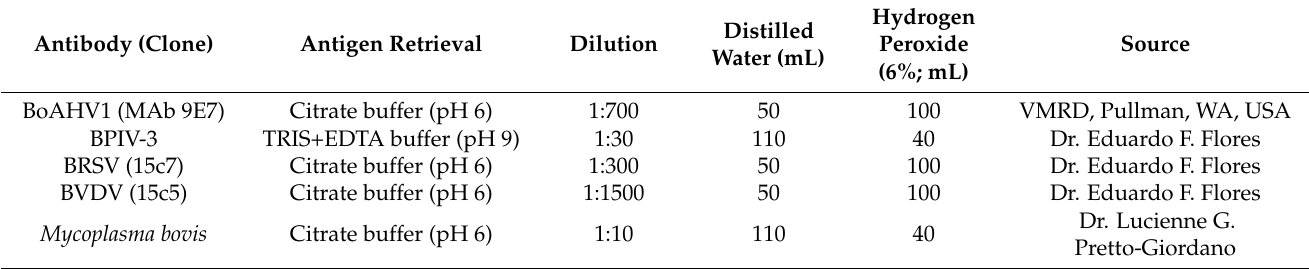
Table 1. Antibodies, dilutions, and antigen retrieval methods used in immunohistochemical assays.